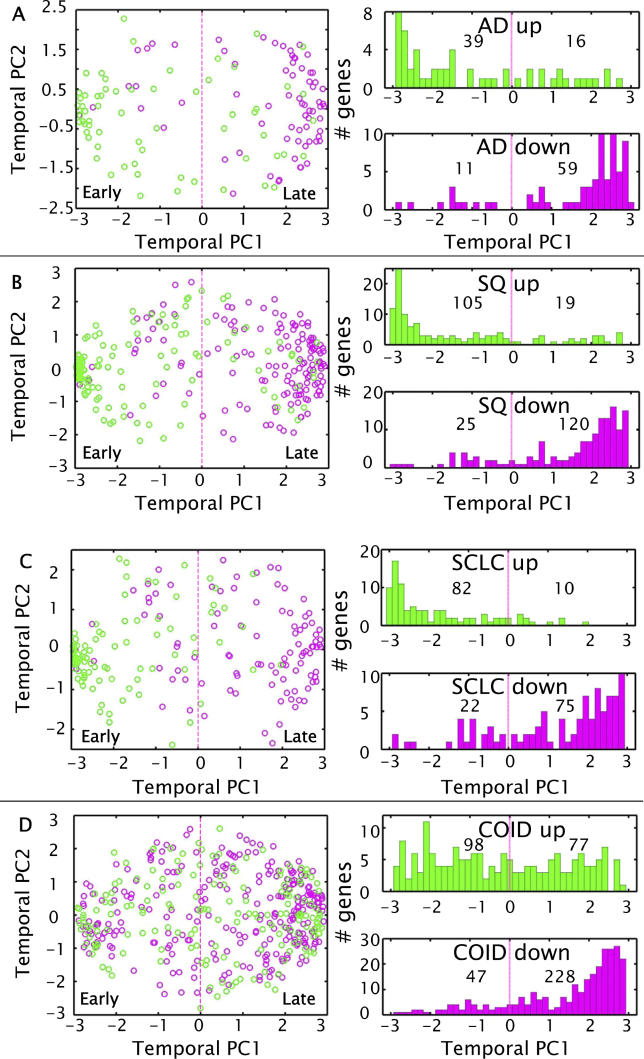
Temporal Analyses of the Significantly Differentiated Lung Cancer Genes in Murine Lung DevelopmentAnalysis of mouse lung development profiles of genes 2-fold significantly up- or down-regulated in each of the four human lung cancer subtypes in relation to all 3,590 gene profiles in temporal PC1 and PC2 confirms a developmental association at the gene-by-gene scale. Shown are the mouse lung development profiles of 2-fold significantly up-regulated (green circles) and down-regulated (magenta circles) genes in human lung cancer subtypes relative to NL.(A) Up- and down-regulated genes in AD (χ
2 = 36.83,
p < 0.001, OR = 13.074).
(B) Up- and down-regulated genes in SQ (χ
2 = 119.036,
p < 0.001, OR = 26.526).
(C) Up- and down-regulated genes in SCLC (χ
2 = 81.584,
p < 0.001, OR = 27.955).
(D) Up- and down-regulated genes in lung COID (χ
2 = 72.363,
p < 0.001, OR = 6.174).